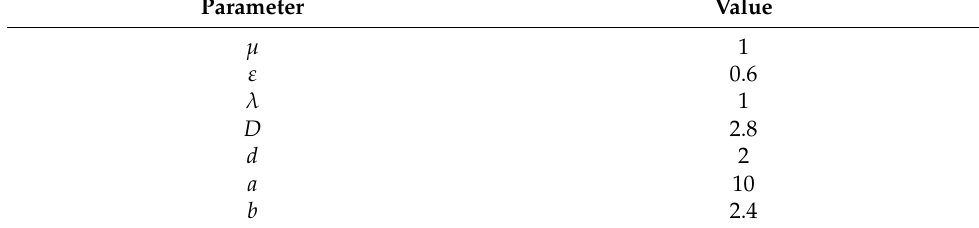
Table 1. General parameters used for simulation.